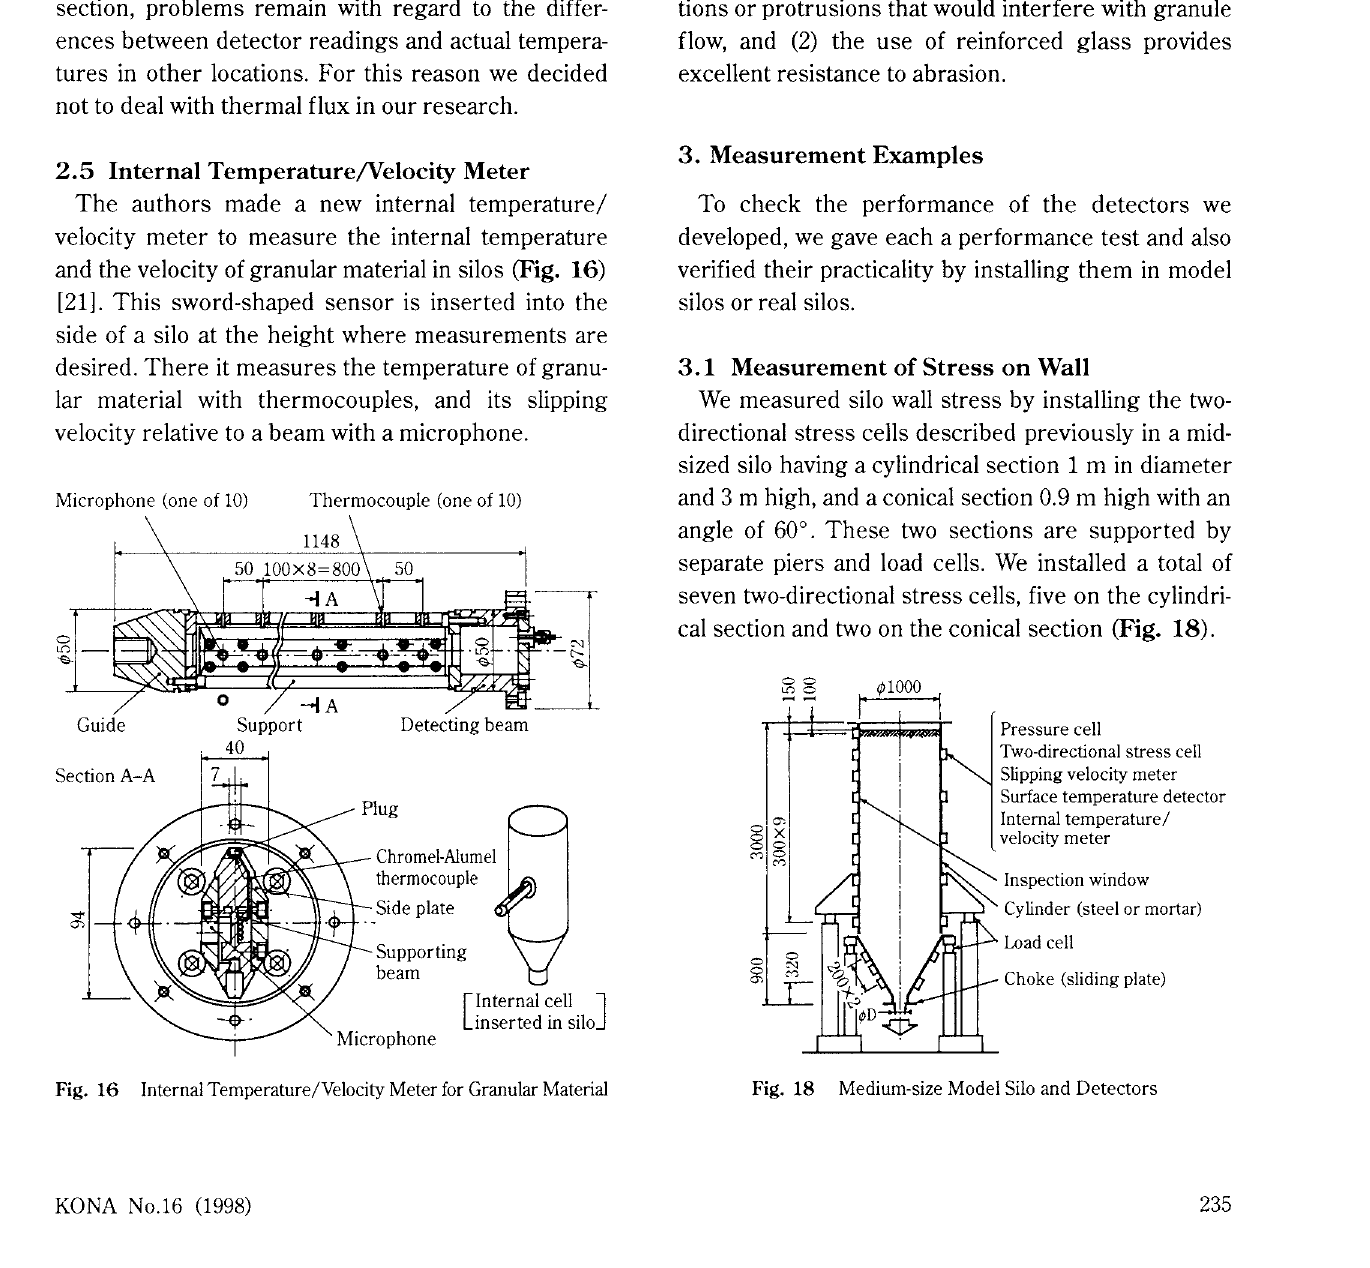
KONA No.16 (1998)